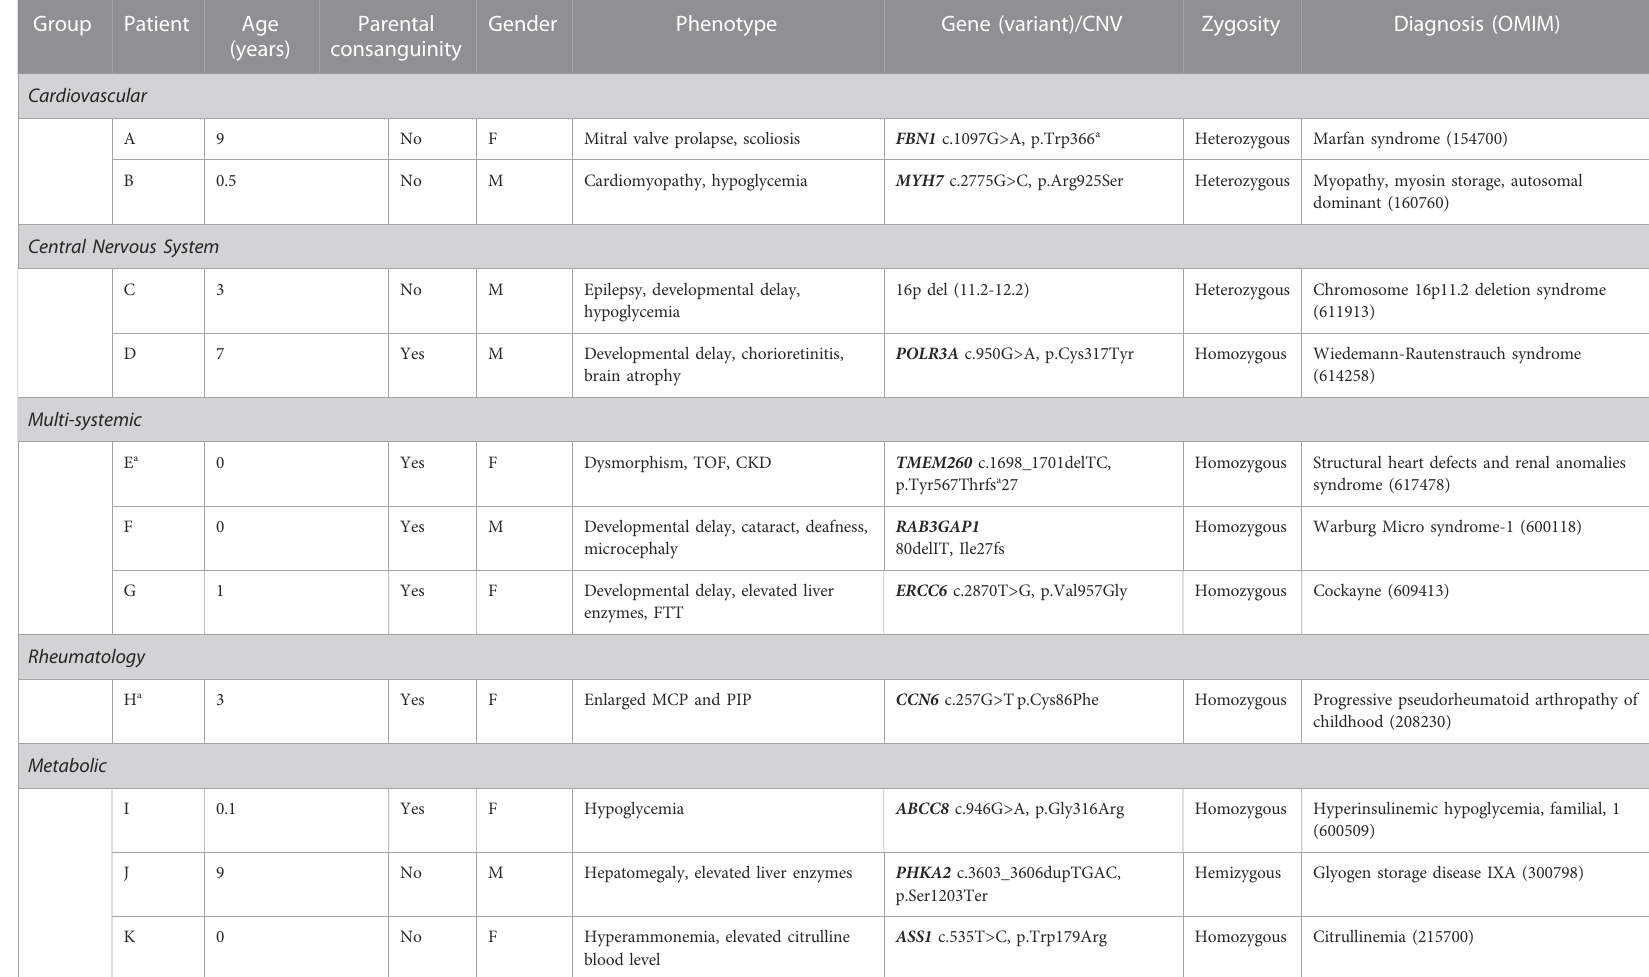
TABLE 1 Characteristics of a historical cohort of undiagnosed children which were solved following exome